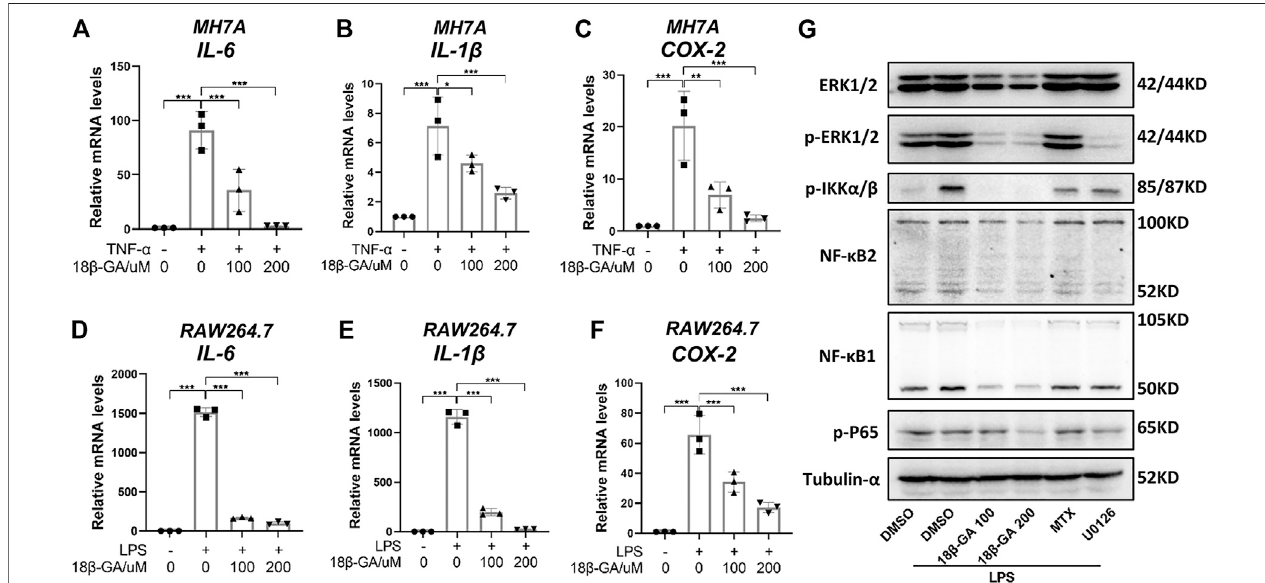
FIGURE1| 18 β -GAattenuatesin fl ammationbyregulatingtheMAPK/NF- κ Bsignalingpathway. (A – C) MH7AcellswerepretreatedinDMEMwithoutFBSovernight and then the cells were exposed to TNF- α (100 ng/ml) and 18 β -GA (100 and 200 μ M) for 3 h. Relative mRNA levels of IL-6, IL-1 β , and COX-2 were measured by RT- qPCRinMH7A cells.Dataareshownasmean ± SD.*, ** ,and *** mean p < 0.05, p < 0.01,and p < 0.001, n (cid:2) 3. (D – F) RAW264.7cellswerepretreated inDMEM without FBS overnight and then the cells were exposed to LPS (1 μ g/ml) and 18 β -GA (100 and 200 μ M) for 3 h. Relative mRNA levels of IL-6, IL-1 β , and COX-2 were measuredbyRT-qPCRinRAW264.7cells.Dataareshown asmean ± SD. *** p < 0.001, n (cid:2) 3. (G) Theprotein expression ofERK1/2, p -ERK1/2, p -IKK α / β ,NF- κ B2,NF- κ B1, and p-P65 in RAW264.7 cells were analyzed by western blot, and tubulin- α was used as house control ( n (cid:2) 3).